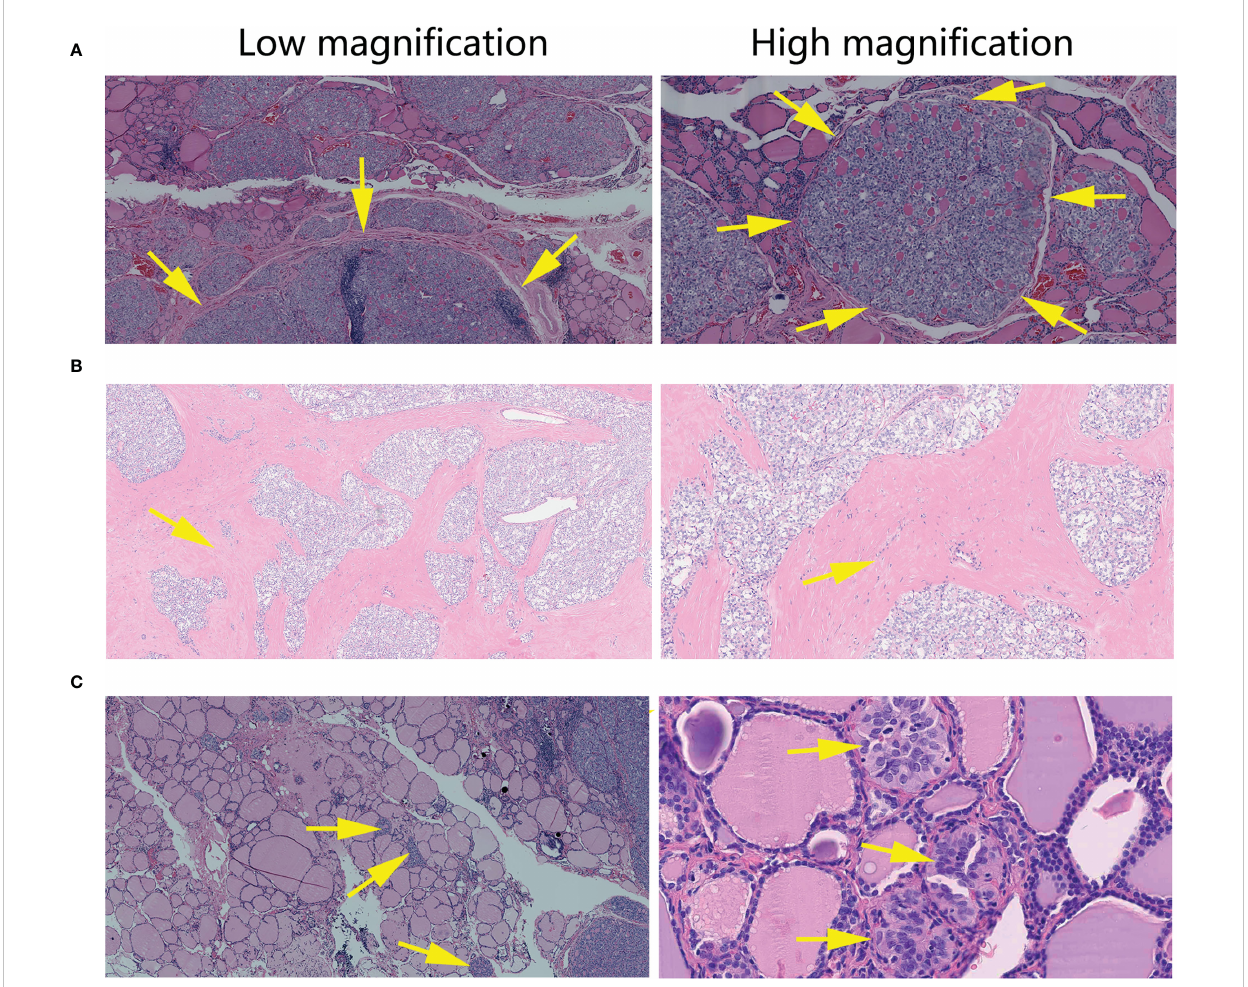
FIGURE 3 Histopathological features of Papillary Thyroid Carcinomas tumors with non-classical phenotype. (A) In 40X and 100X magni fi cation, tumor tissue arranged in smooth-bordered nodules (arrow), as separated by normal thyroid tissue. (B) In 40X and 100X magni fi cation, tumor tissue arranged in a geographic, jigsaw-like pattern within a broad fi brous background (arrow). (C) 40X and 400X magni fi cation shows small satellite nodules (arrow) near or away from the dominant